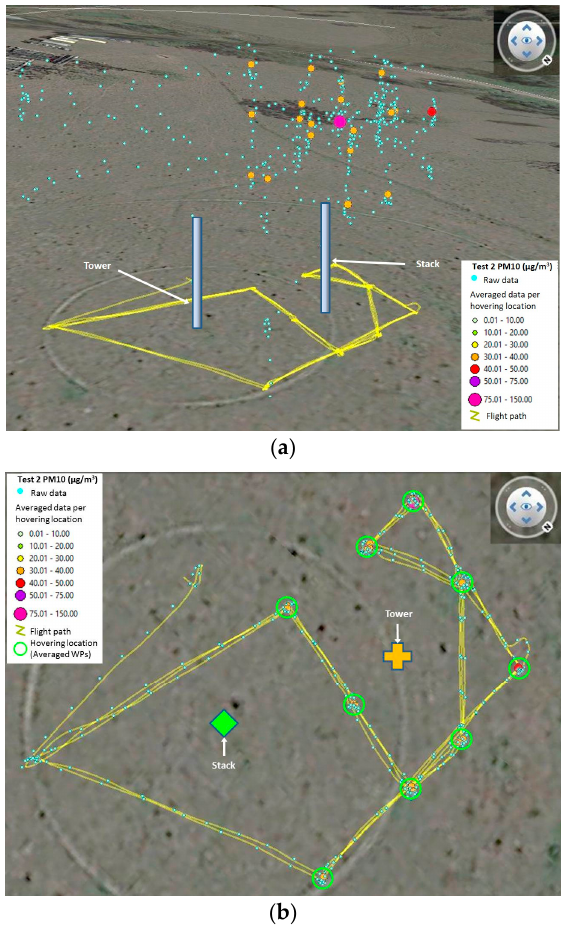
Figure 19. Field data collected for Test 2 with the airborne module before and after processing, ( a ) 3D view, and ( b ) top view with averaged locations indicated (repeated per height programmed).